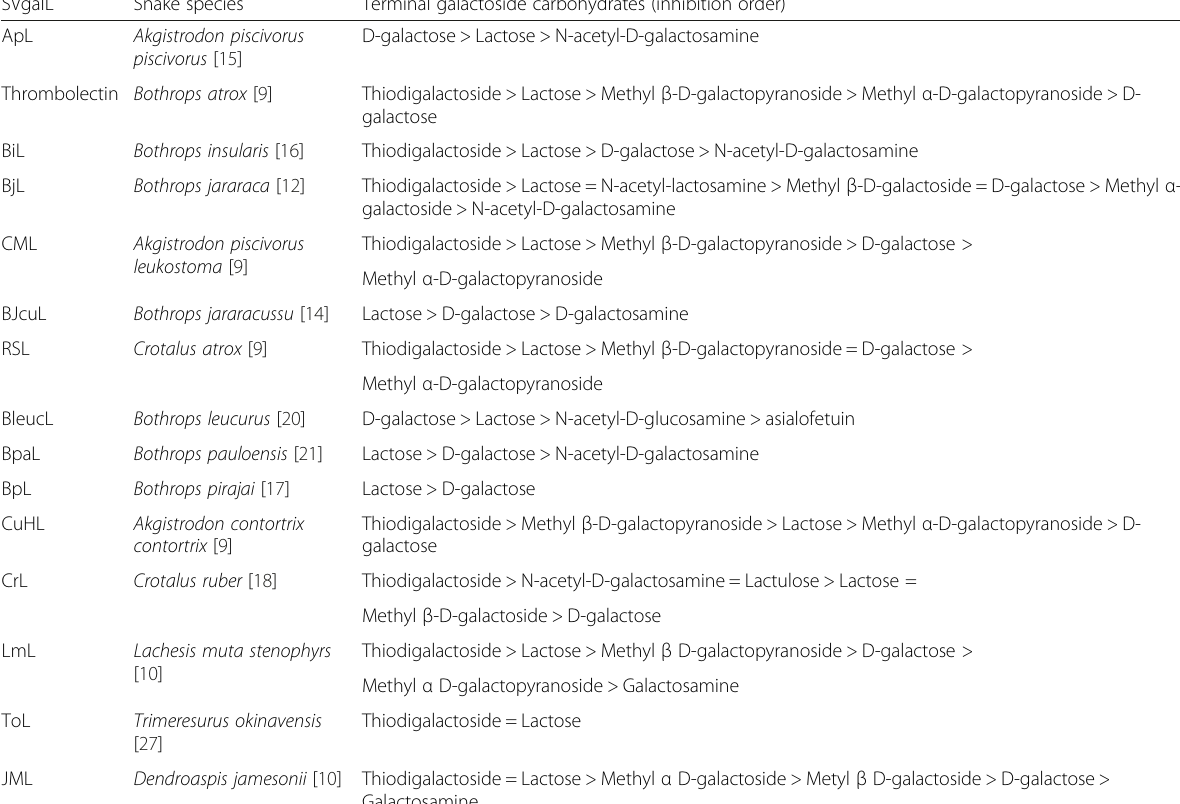
Table 1 Carbohydrate inhibition specificity of